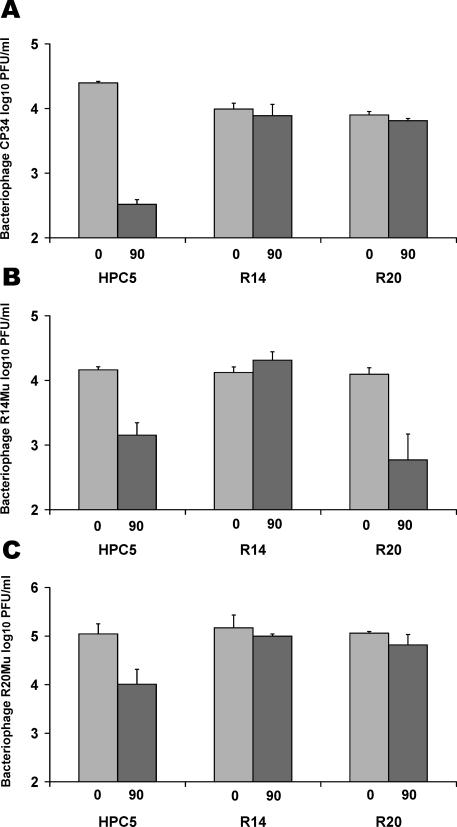
Binding Assay of Bacteriophage CP34, R14-CampMu, and R20-CampMu to C. jejuni HPC5, R14, and R20Graphs indicating the reductions in bacteriophage titre following a 90-min incubation with C. jejuni HPC5, R14, and R20 at 42 °C with 100 rpm shaking. Error bars represent ±1 standard deviation. The top graph shows the interaction with virulent bacteriophage CP34, the middle graph shows the interaction with temperate phage R14-CampMu, and the bottom graph shows the interaction with temperate phage R20-CampMu.